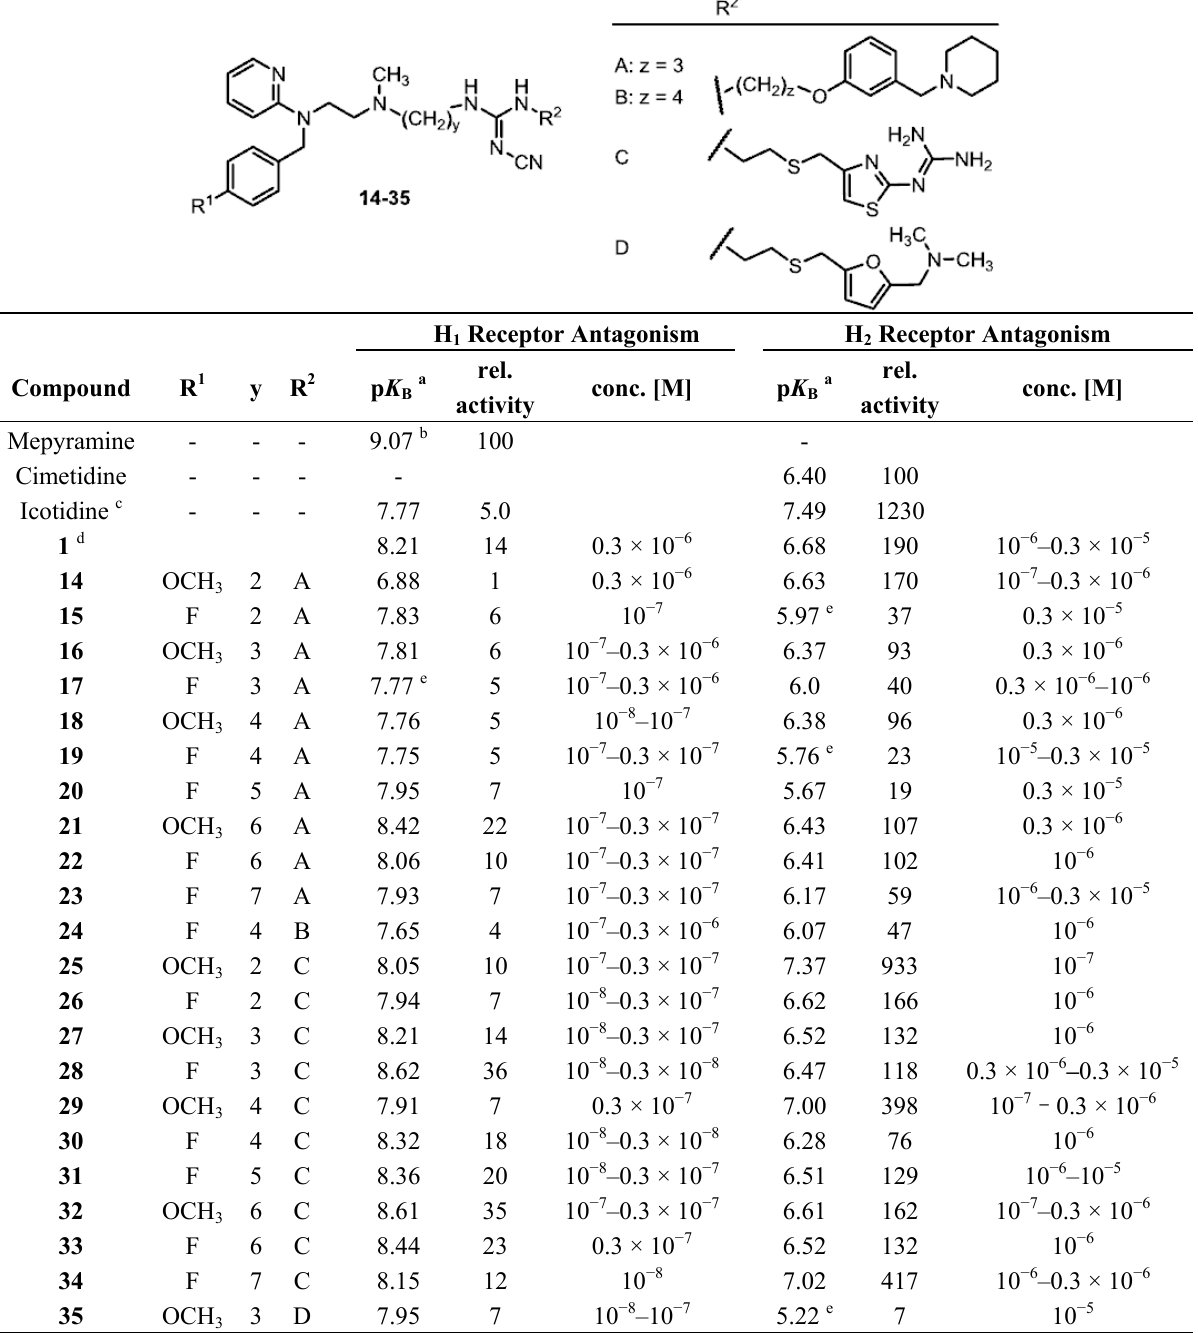
Table 1. Histamine H